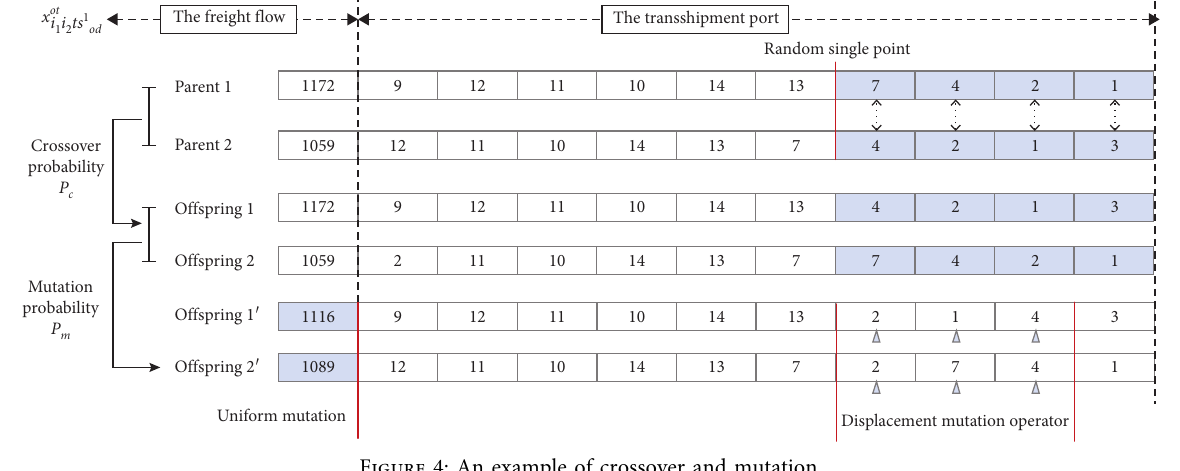
Figure 4: An example of crossover and mutation.